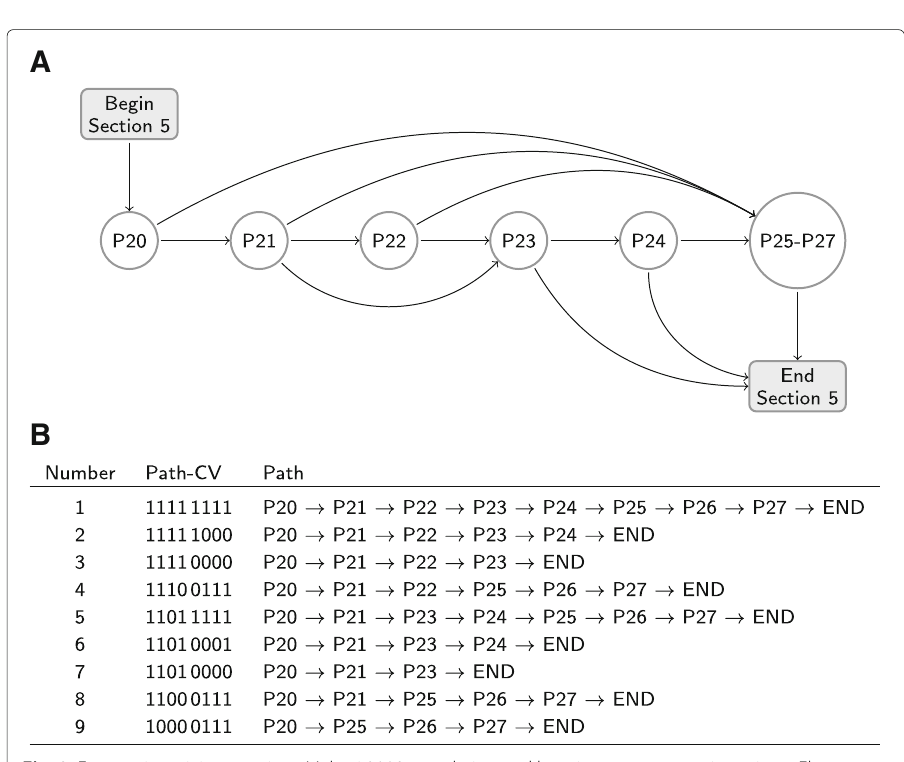
Fig. 2 Economic activity questions Malawi 2008 population and housing census questionnaire. a Flow diagram of questions and progressions. See questionnaire (Minnesota Population Center, 2018b) or Fig. 3 for questions, possible responses, and interviewer instructions. b List of paths. See “Application of the paths algorithms” section for explanation of Path-CV